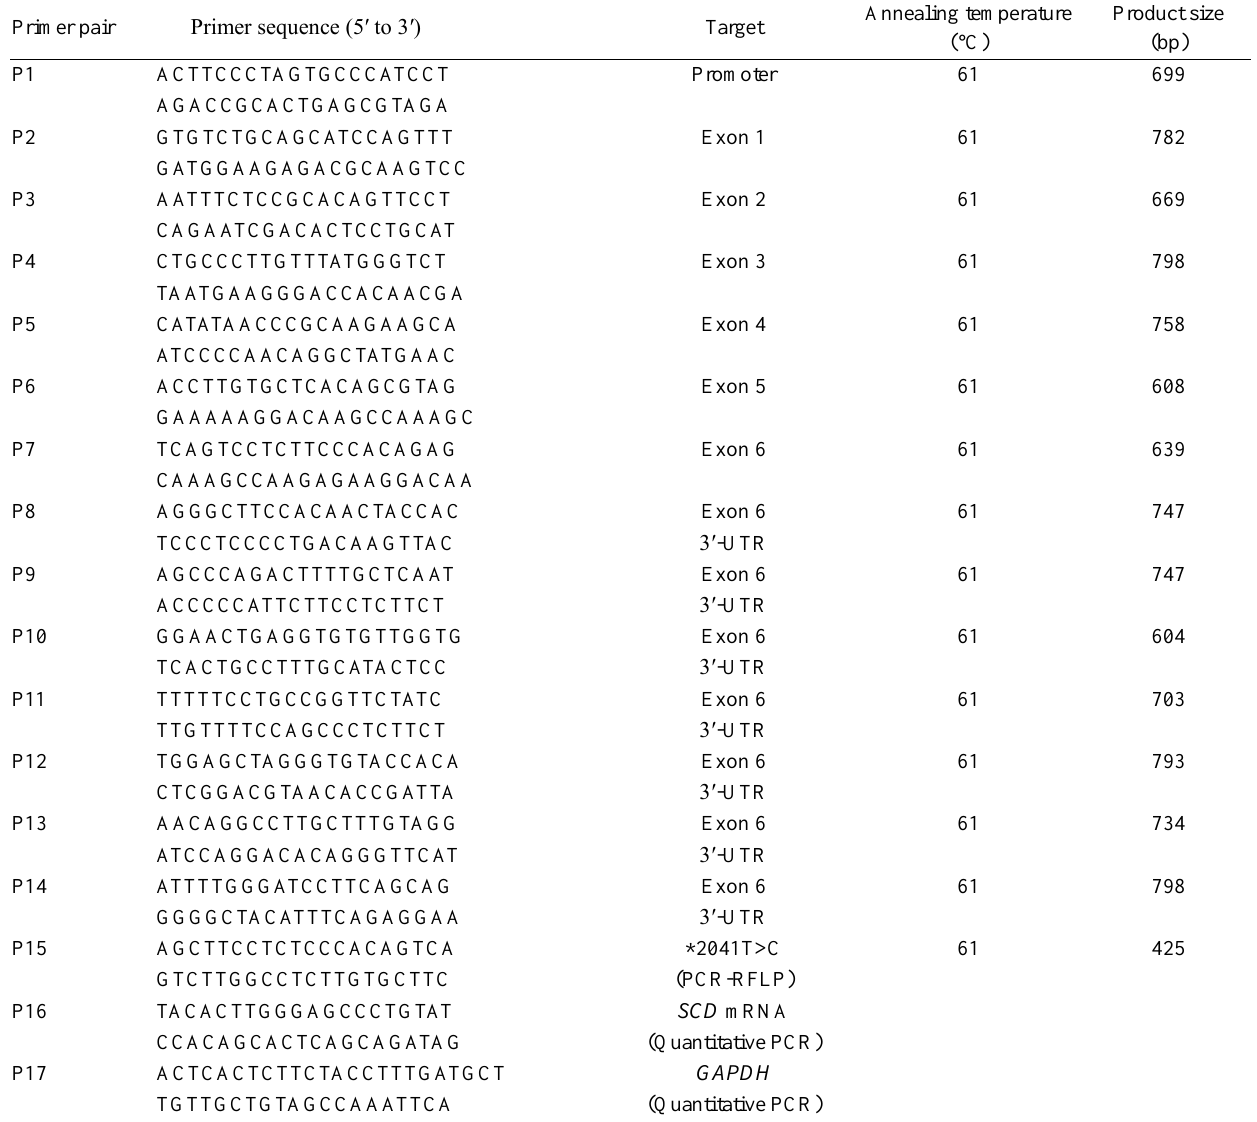
Table 3. Sequences of primers used for polymerase chain reaction amplification and quantitative polymerase chain